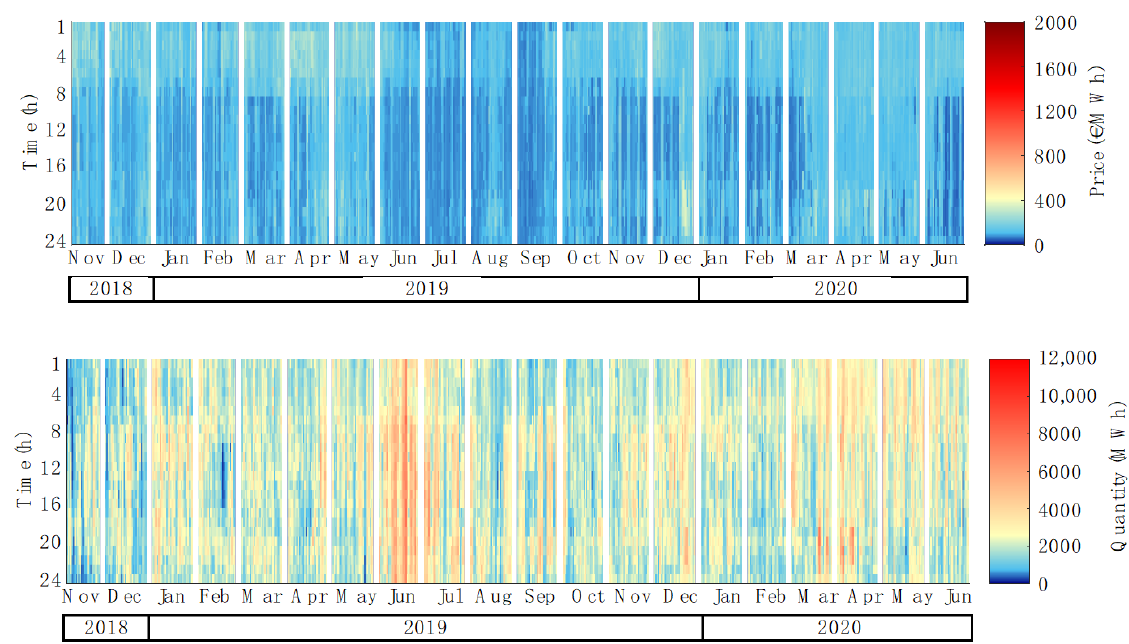
price (upper chart) and the overall quantity (lower chart) of accepted upward bids on the Italian ASM. Similar to that, Figure A3 reports heatmaps that outline the development of the weighted average price (upper chart) and the overall quantity (lower chart) of accepted downward bids on the Italian ASM. Please note that the payment direction is inverse for downward services, i.e., from operators to the TSO, hence higher prices are here more competitive than lower ones.